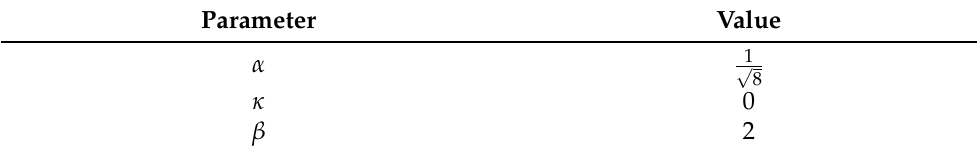
Table 2. UT Parameters.